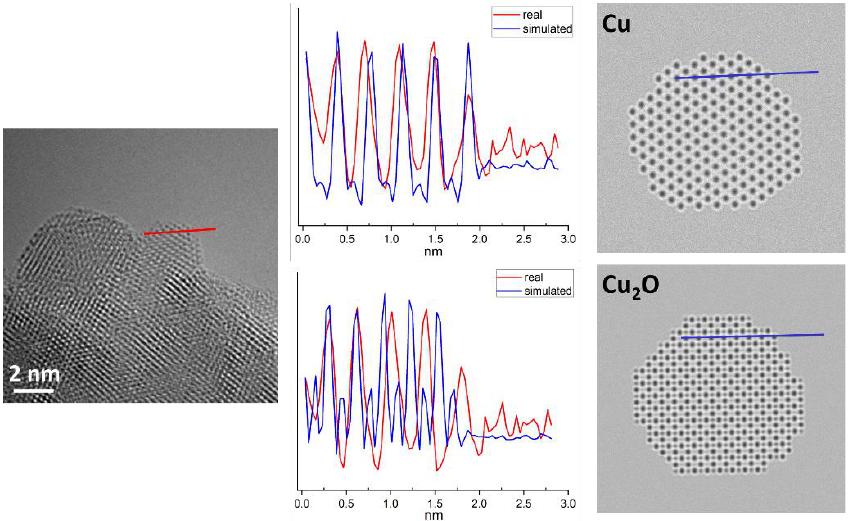
Figure 5. Determining the phase of the new structure. Intensity profiles of the simulated HRTEM micrographs of Cu and Cu 2 O ( right ) compared with that of the experimental HRTEM micrographs ( left ).